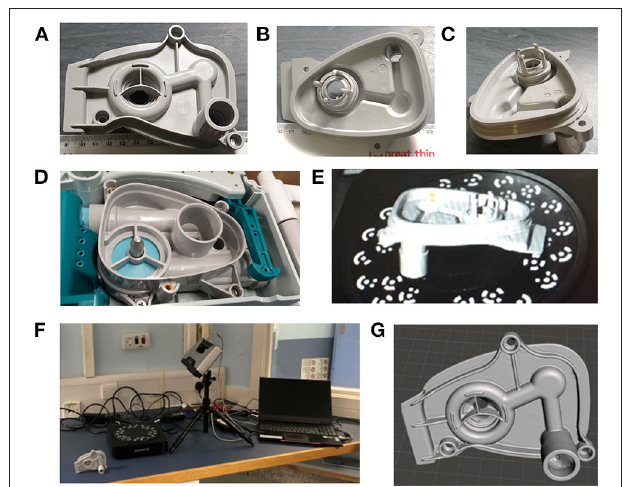
FIGURE 1 | (A–C) Different views of the manifold for the Carestation. (D) The position into which the manifold fits in the Carestation. (E) Depiction of the part in the scanner. (F) The Einscan Pro setup used to scan the part. (G) The surface mesh after manual